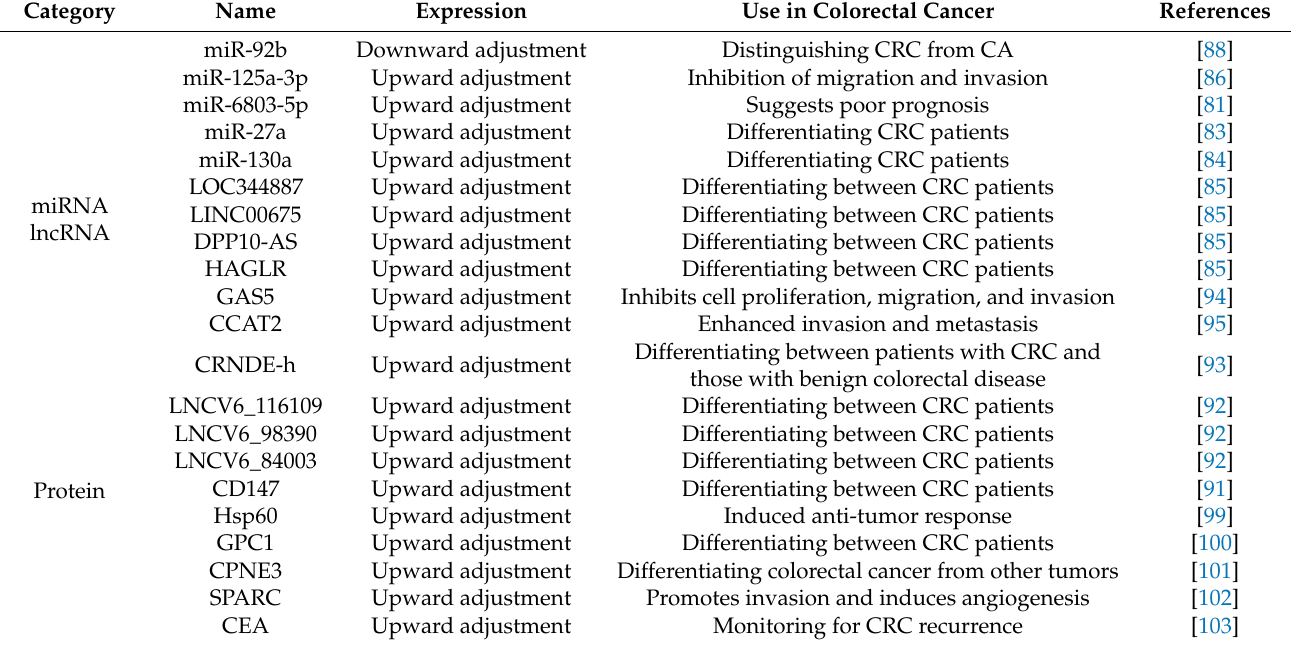
Table 1. Mechanisms of different exosomes in the diagnosis of